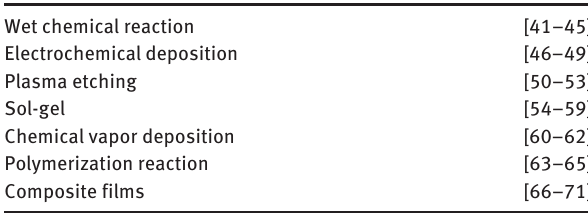
Table 1 Strategies suggested to produce superhydrophobic materials and corresponding